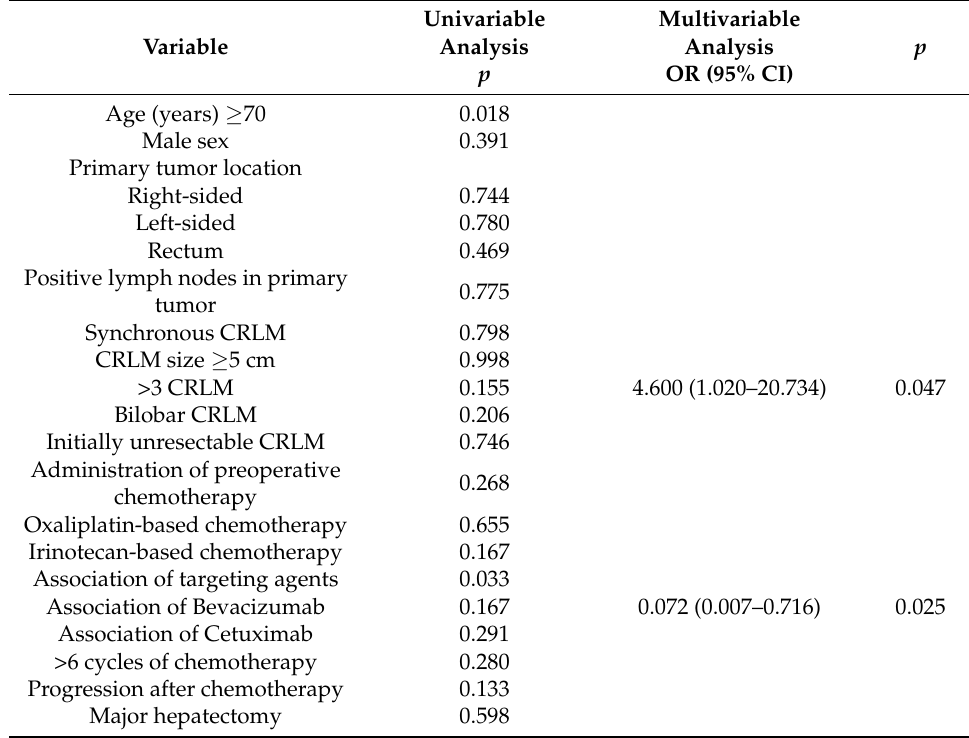
Table 4. Univariable and multivariable logistic regression analysis for the risk of KRAS discordance associated with the worst prognosis (wild-type in primary tumor, mutation in